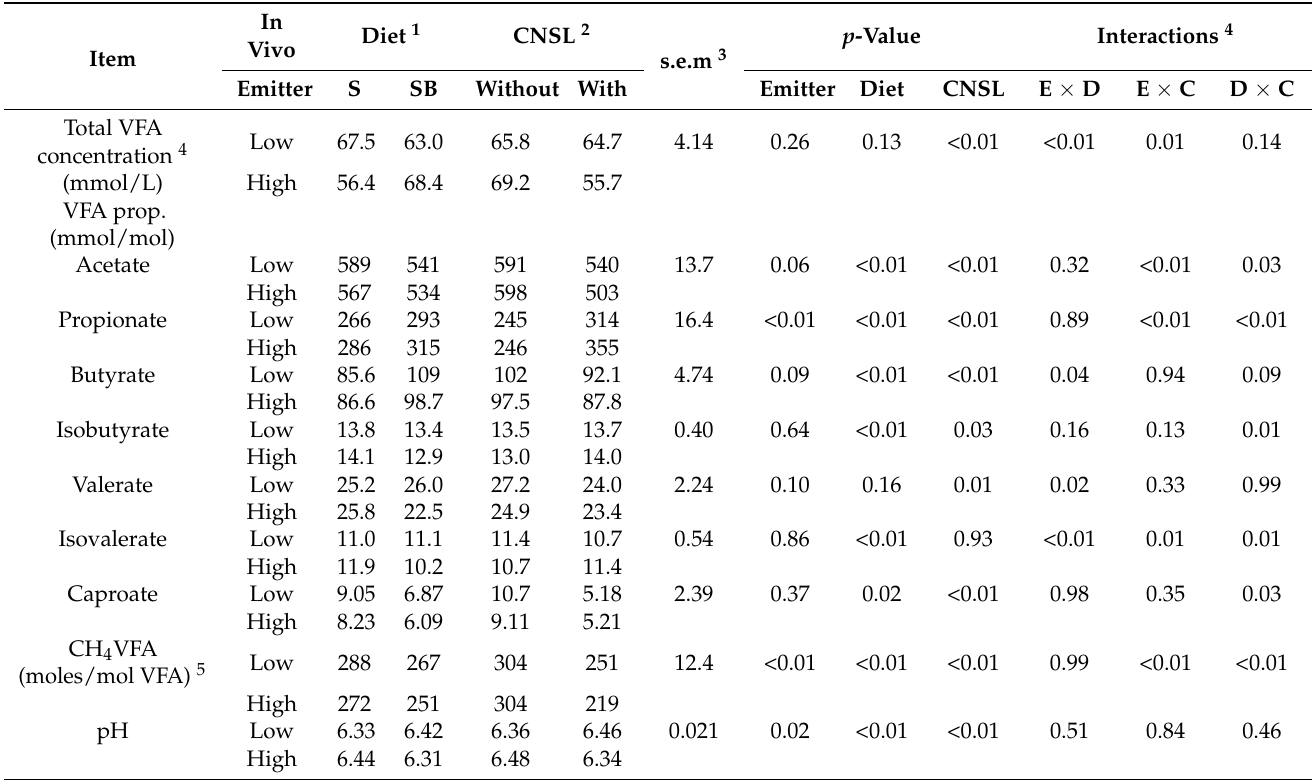
Table 5. Total volatile fatty acids and production of each individual VFA after 48 h incubation from substrates incubated in rumen fluid from both low and high emitters in vivo in the gas in vitro system ( n = 7 runs/ pairs of cows).